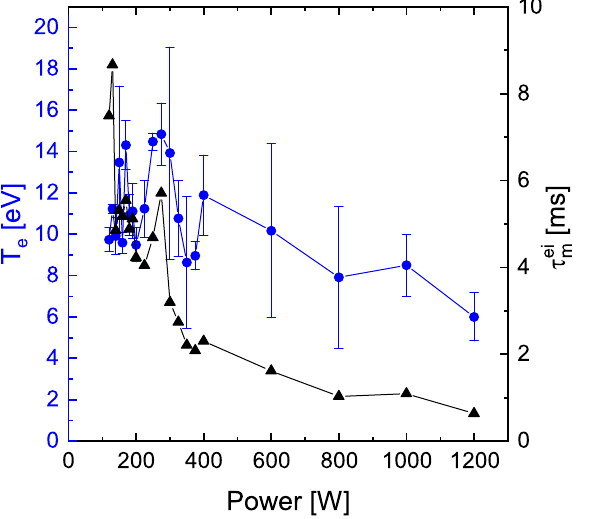
FIG. 6. Comparison between the trend of T e vs the rf power with the corresponding energy transfer average time, as deter- mined by Eq. (3).